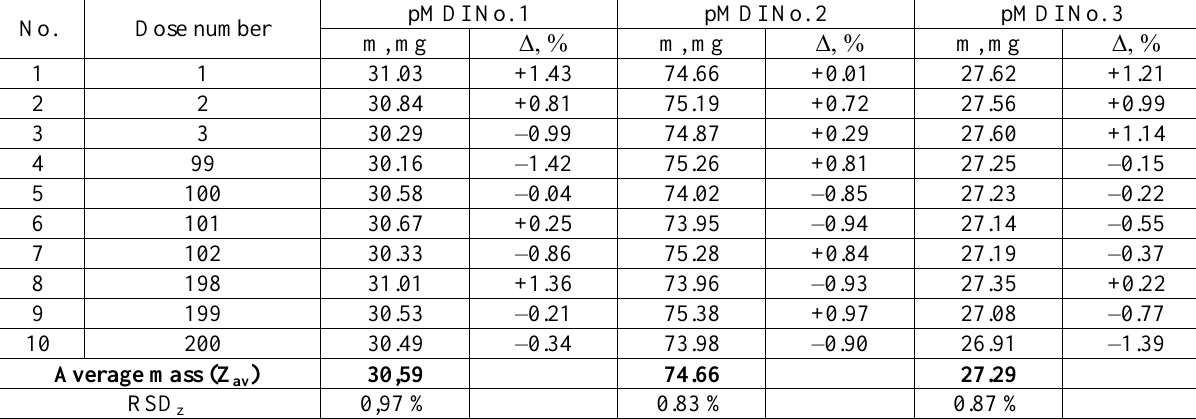
The results of the tests in regard to dose mass (m) and uniformity of dose for the pMDIs with salbutamol sulfate (SS)